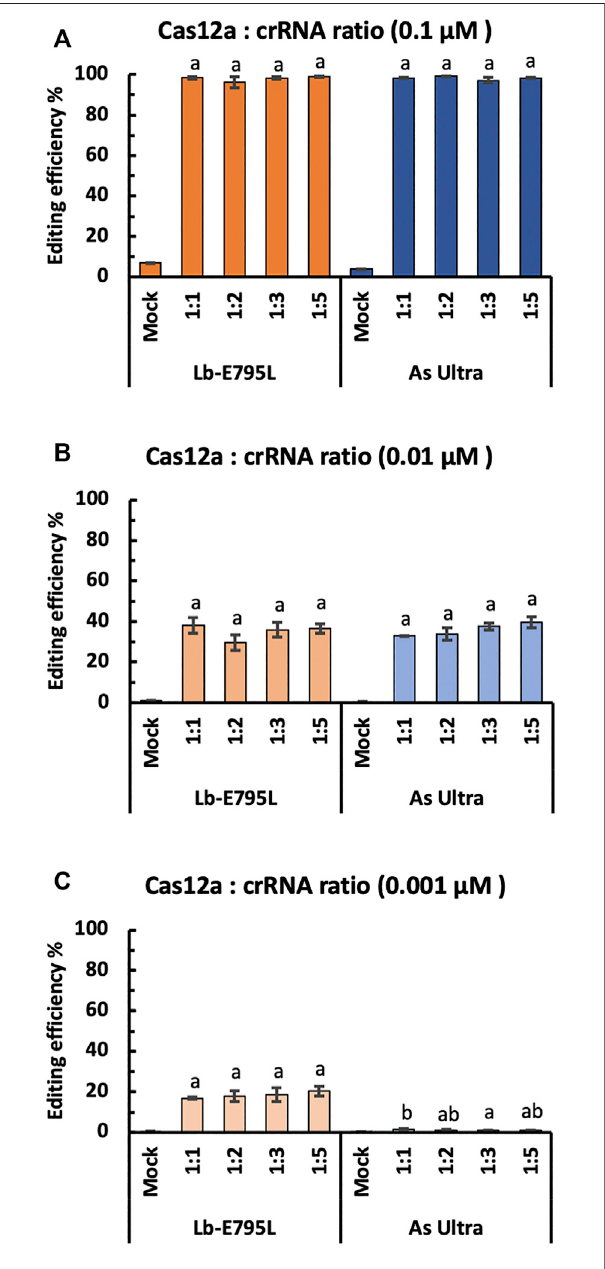
FIGURE4| Cas12a editingef fi ciencies at different Cas12a:crRNAratios in ricecells with RNPdelivery.Editingef fi ciencies oftwoCas12a variants were tested in rice cells with RNP delivery at the OsEPFL9 site at 32 ° C. Editing ef fi ciencies are calculated using the RFLP assay with three RNP concentrations, 0.1 µM (A) , 0.01 µM (B) and 0.001 µM (C) . Data are presented as mean values ±SEM of three biologically independent replicates. Editing ef fi ciencies using four different Cas12a:crRNA ratios are compared using Tukey ’ s Honest Signi fi cant Difference (HSD) test. Treatments with the same letter are not signi fi cantly different when α =